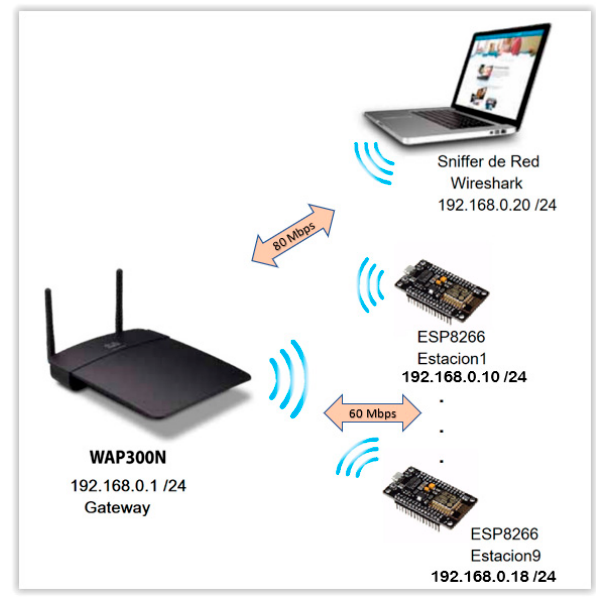
Figure 1. Assembly diagram of the Wireless Sensor Network (WSN).